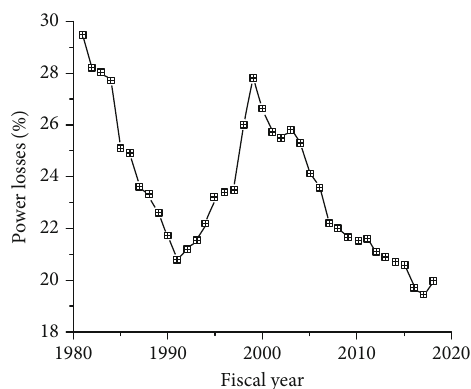
Figure 5: Power losses at transmission and distribution from 1981 to 2018.